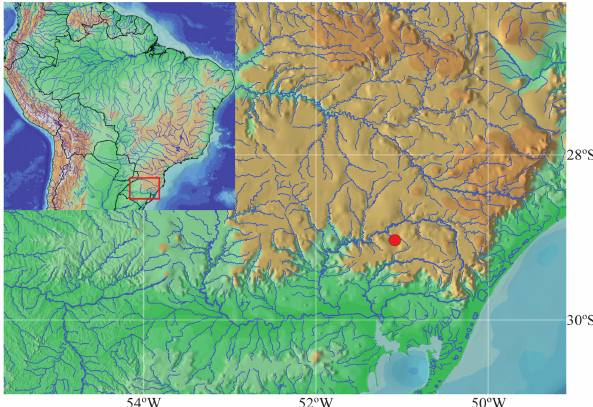
Fig. 5. Rio Jacuí basin showing the collecting site and type locality (red dot) of Oligosarcus varii